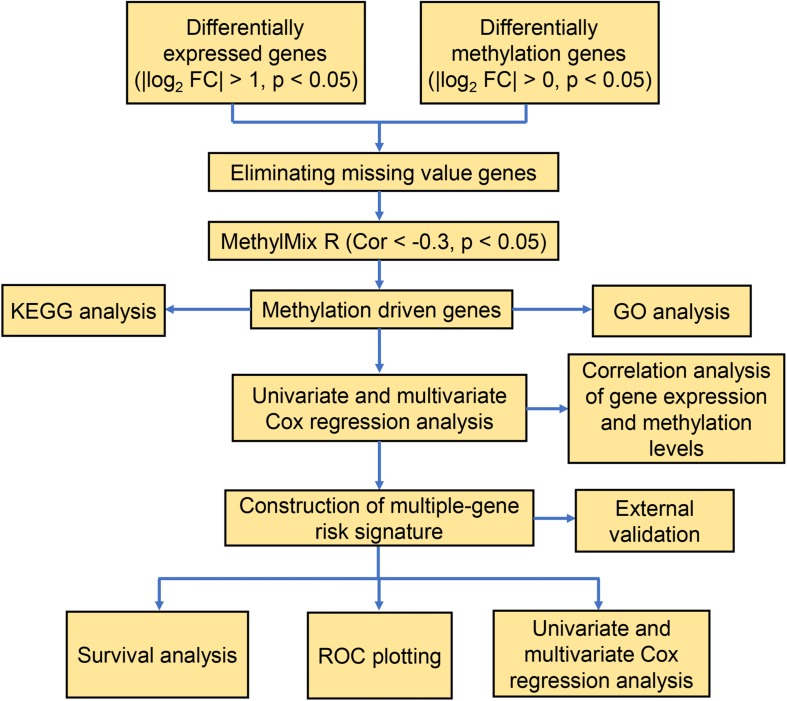
A flow chart of the exploration of methylation-driven genes in thyroid cancer.